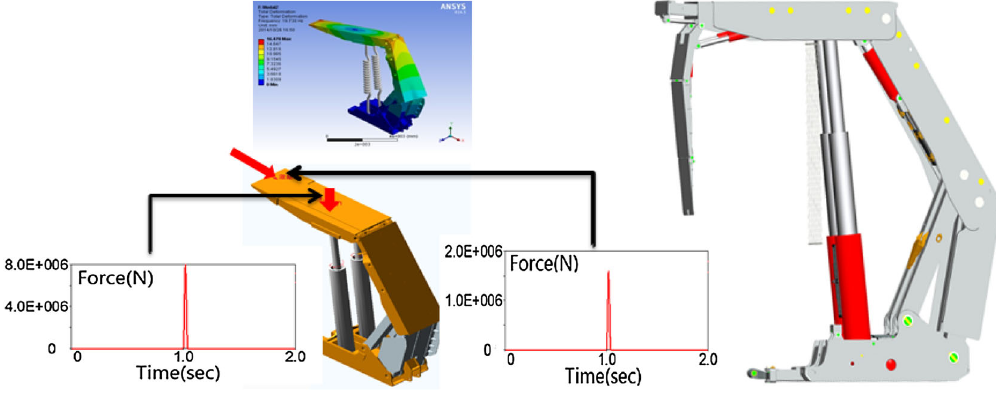
Fig. 2 Hydraulic support three-dimensional dynamic optimization design